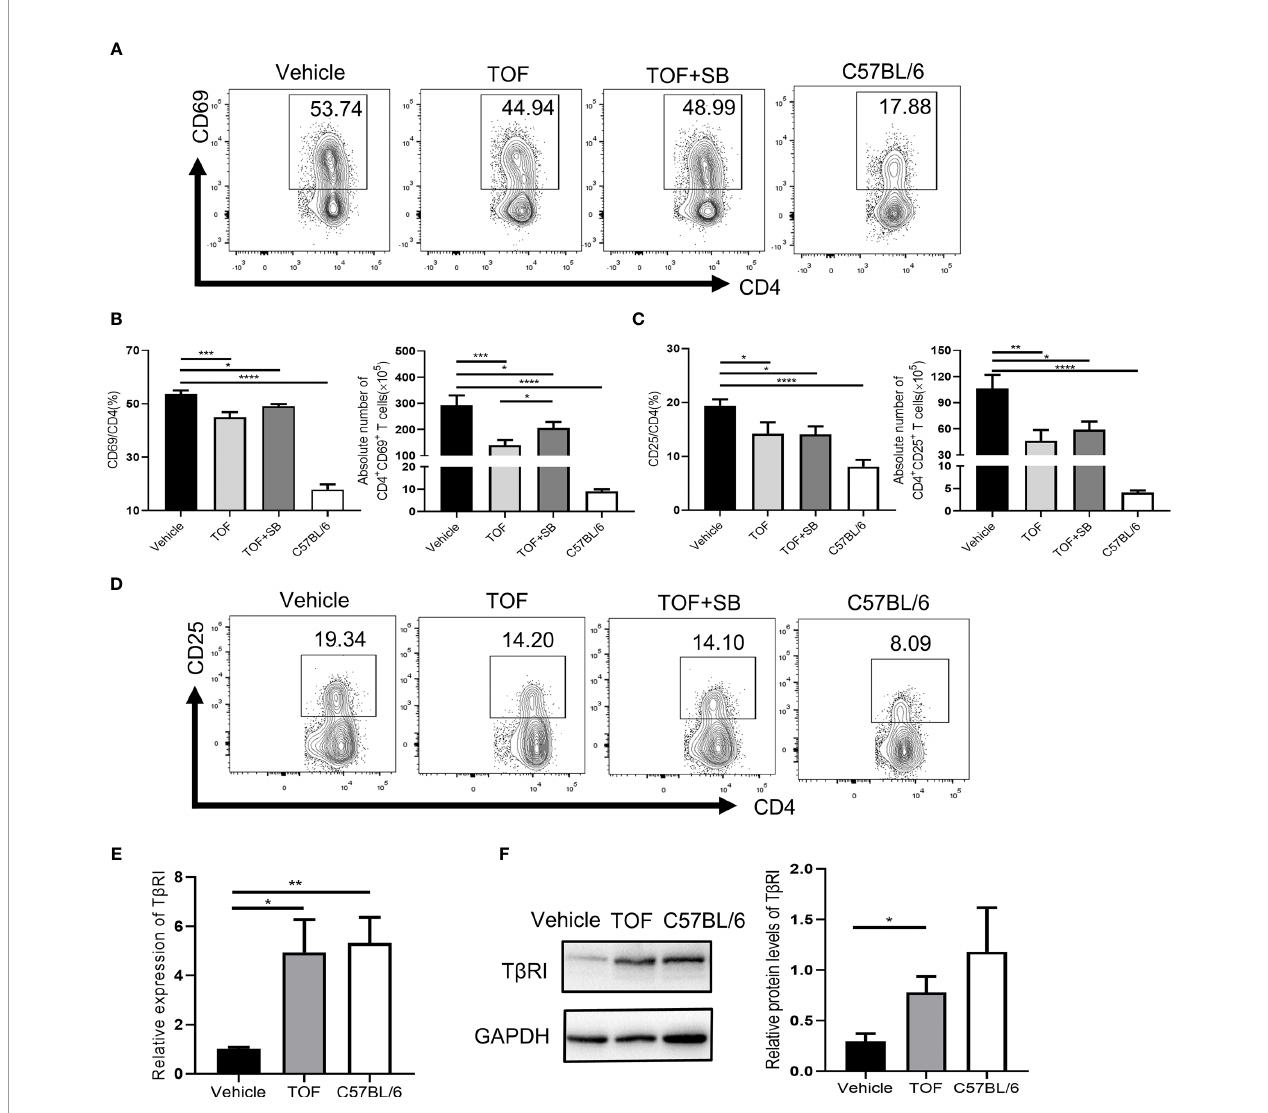
FIGURE 5 | Tofacitinib increases TGF b RI expression and suppresses CD4 + T cell activation in vivo . (A) Percentages of CD4 + CD69 + T cells were determined by fl ow cytometric analysis. (B) The percentages and numbers of CD4 + CD69 + T cells were shown. (D) Percentages of CD4 + CD25 + T cells were determined by fl ow cytometric analysis. (C) The percentages and numbers of CD4 + CD25 + T cells were shown. (E) The expression of TGF b RI (T b RI) in CD4 + T cells from MRL/lpr mice was determined by real-time PCR. n = 8 for each group. (F) The protein levels of TGF b RI in CD4 + T cells from MRL/lpr mice, as determined by Western blotting (n = 3). Error bars indicate SEM. * P < 0.05, ** P < 0.01, *** P < 0.001 and **** P < 0.0001. TOF, tofacitinib; SB,